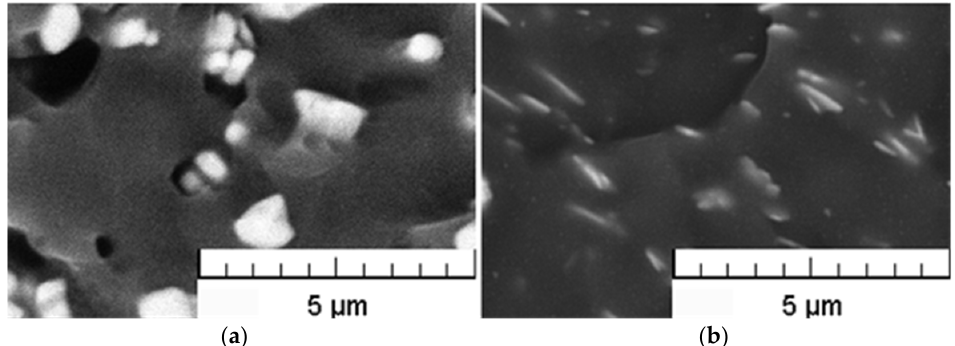
Figure 6. SEM details of the cross-sections of BaSO 4 /PVC ( a ) and BiOCl/PVC ( b ) samples.